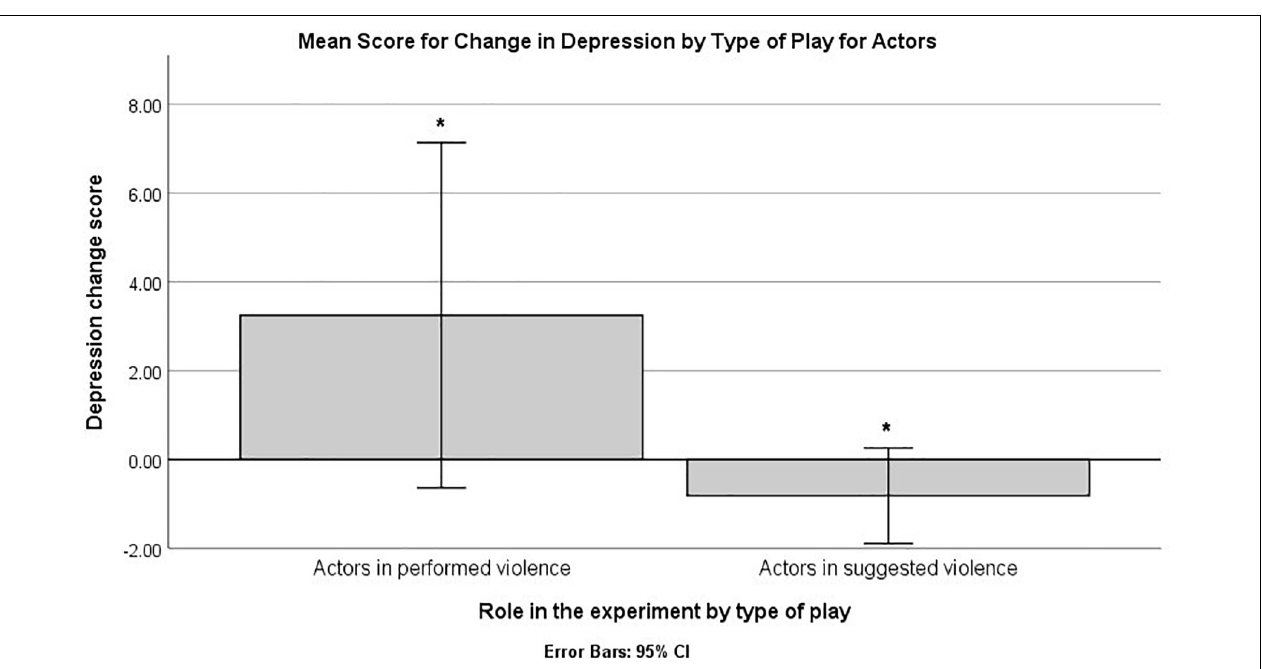
(ANOVA), using the type of play, role in the experiment, and their interaction as between-subject factors in the model. The results indicated a significant main effect for the type of play, F (1,